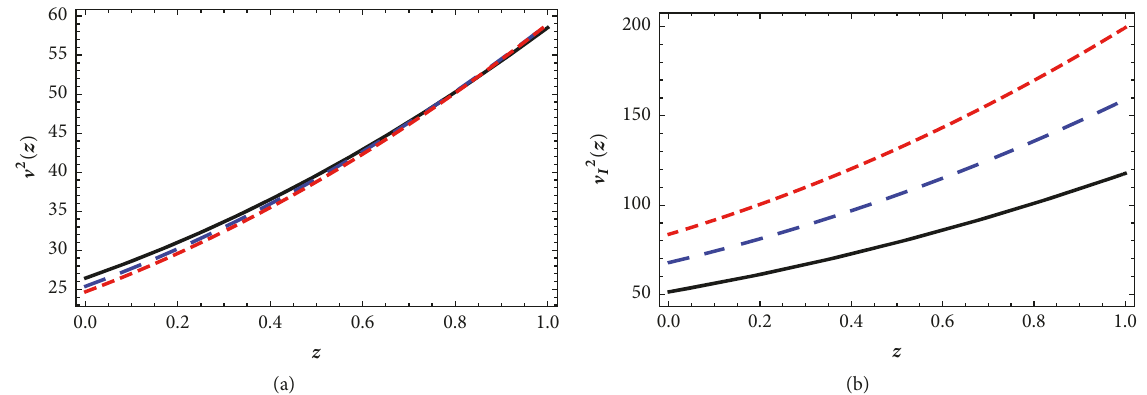
Figure 5: Evolution of square speed of sound as function of red-shift 𝑧 for 𝛼 = 0.8502 and 𝛽 = 0.4817 , (a) noninteracting and (b) interacting